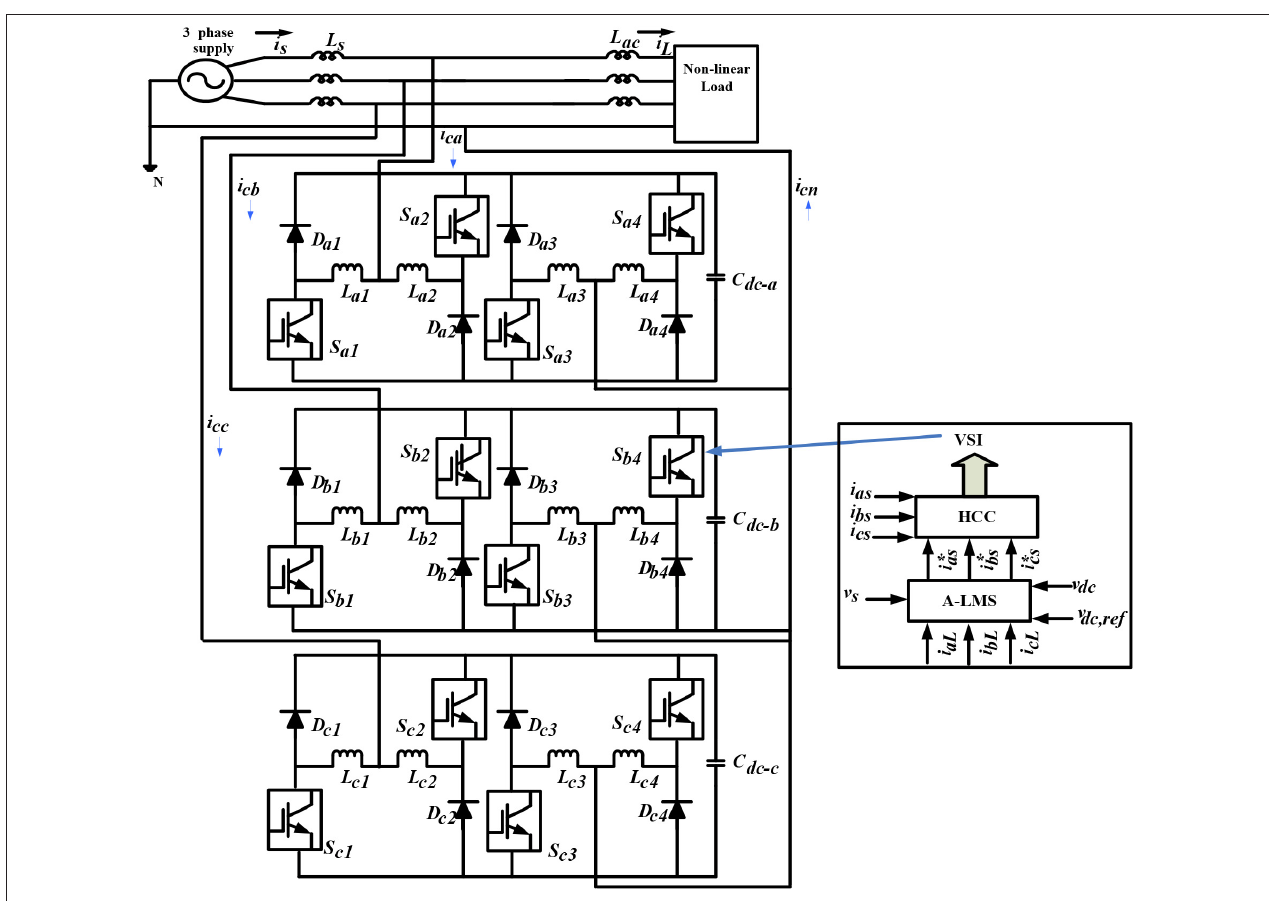
FIGURE 1 | Proposed system